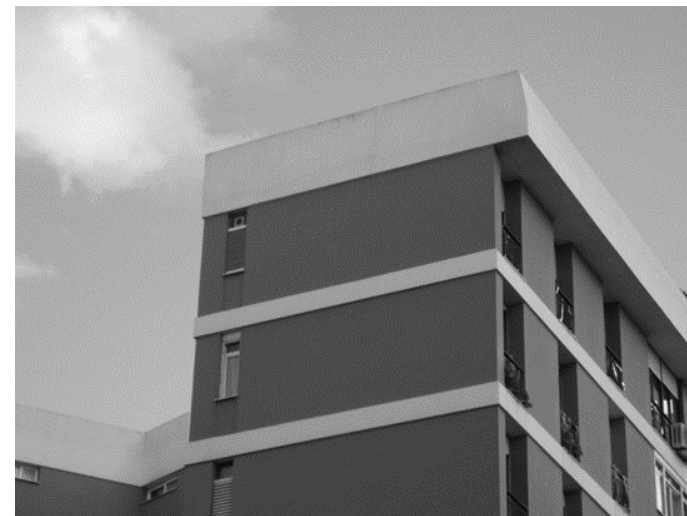
Figure 24. Detail of the cornice.